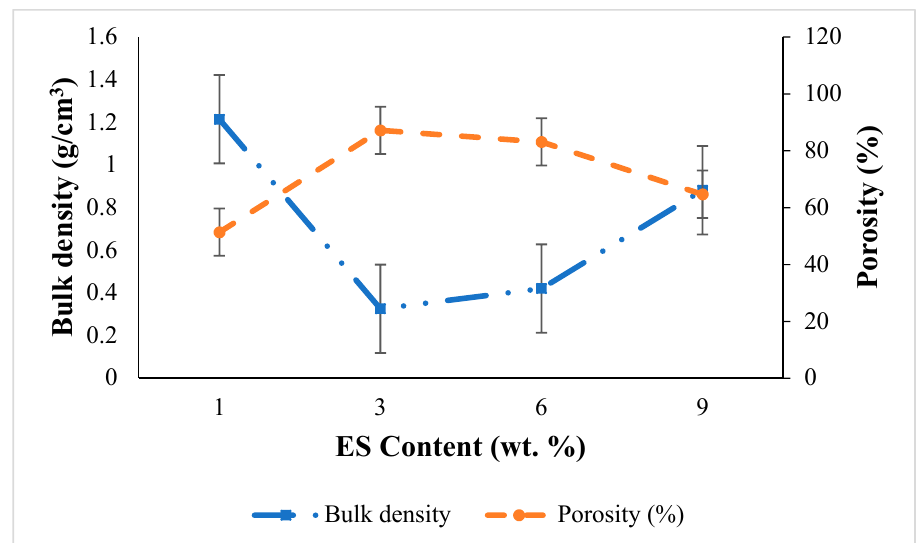
Figure 3. Bulk density-porosity relative to the content of eggshell (ES).